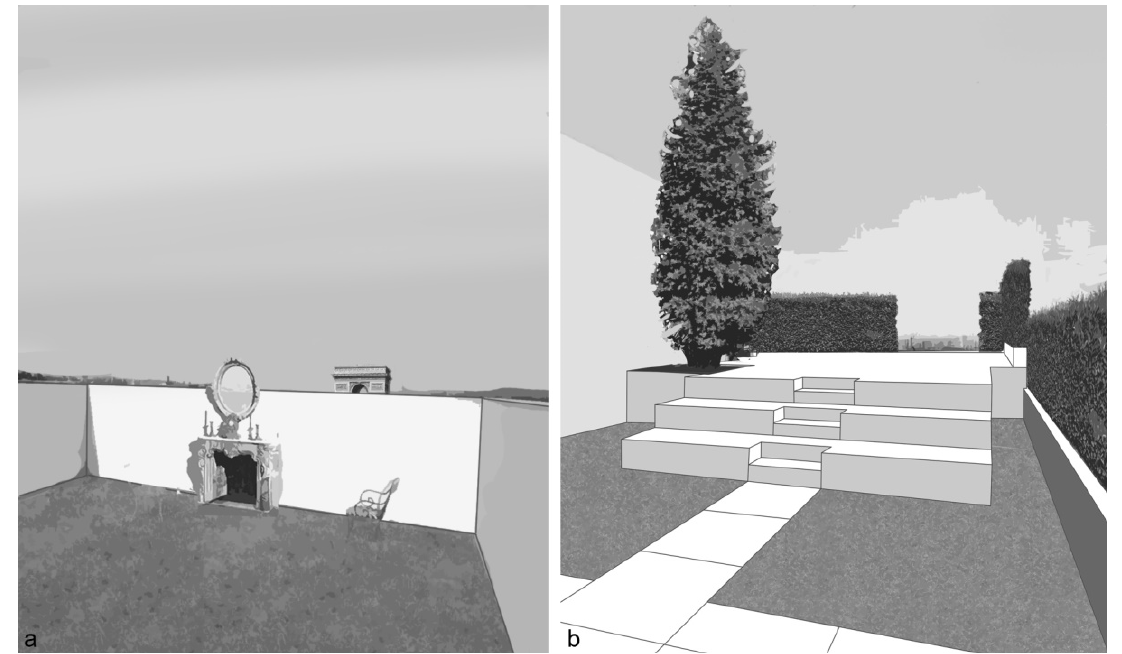
Figure 5. ( a ) Upper terrace—living room; ( b ) lower terrace. Own graphic design 2022.